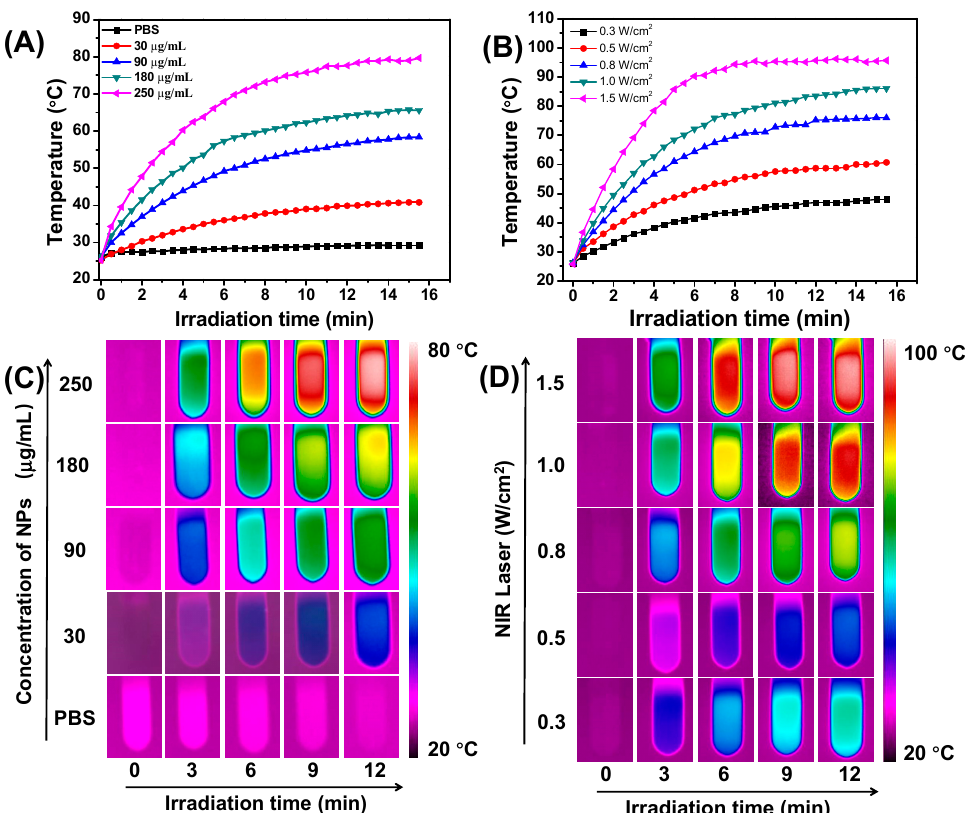
Figure 5. ( A ) Photothermal conversion behavior of TNPs at different concentrations (0–250 μ g/mL) under 880 nm irradiation at 0.7 W/cm 2 , ( B ) Photothermal conversion behavior of TNPs at different laser power (0.3–1.5 W/cm 2 ) under 880 nm irradiation at 0.7 W/cm 2 , and ( C ) IR thermal images of TNPs at different concentrations (0–250 µ g/mL) under 880 nm irradiation at 0.7 W/cm 2 , and ( D ) IR thermal images of TNPs at different laser power (0.3–1.5 W/cm 2 ) under 880 nm irradiation at 0.7 W/cm 2 .